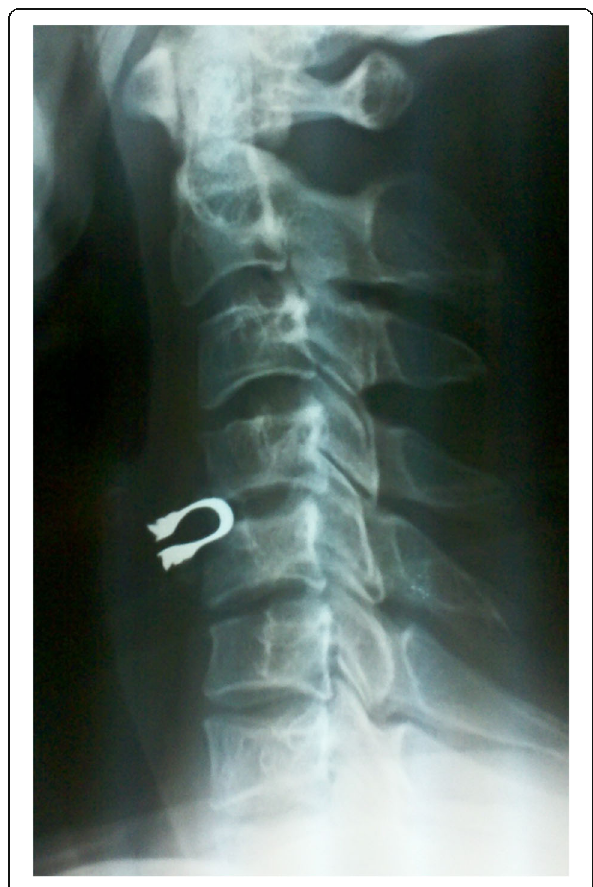
Fig. 6 Plain X-ray lateral view showing anteriorly migrating DCI at C4 – 5